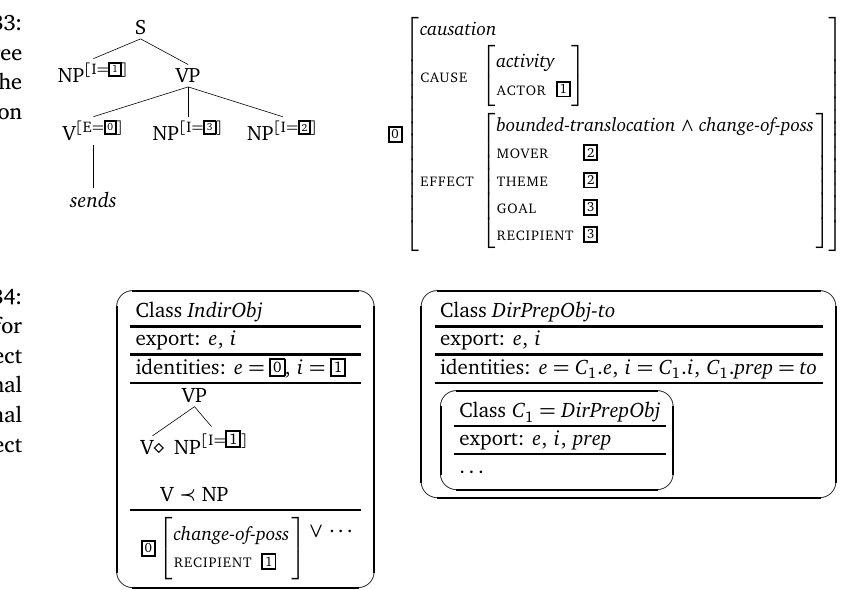
Figure 33: Anchored tree for sends with the DO construction